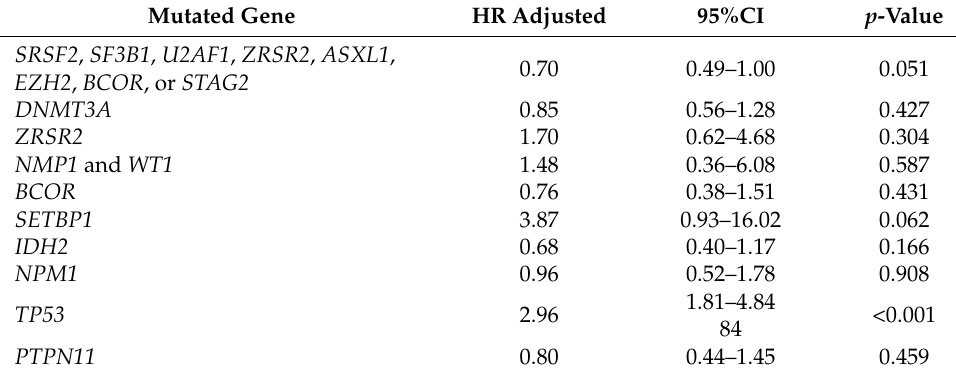
Table 4. Overall survival analysis of patients with selected gene mutations. Mutated Gene HR Adjusted 95%CI p -Value SRSF2 , SF3B1 , U2AF1 , ZRSR2 , ASXL1 , 0.70 0.49–1.00 0.051 EZH2 , BCOR , or STAG2 DNMT3A 0.85 0.56–1.28 0.427 ZRSR2 1.70 0.62–4.68 0.304 NMP1 and WT1 1.48 0.36–6.08 0.587 BCOR 0.76 0.38–1.51 0.431 SETBP1 3.87 0.93–16.02 0.062 IDH2 0.68 0.40–1.17 0.166 NPM1 0.96 0.52–1.78 0.908 1.81–4.84 TP53 2.96 <0.001 84 PTPN11 0.80 0.44–1.45